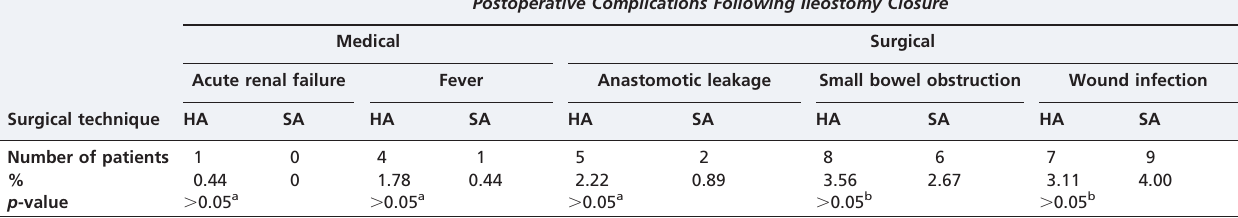
Table 4 - The postoperative medical and surgical complications according to the surgical technique used for the ileostomy closure.